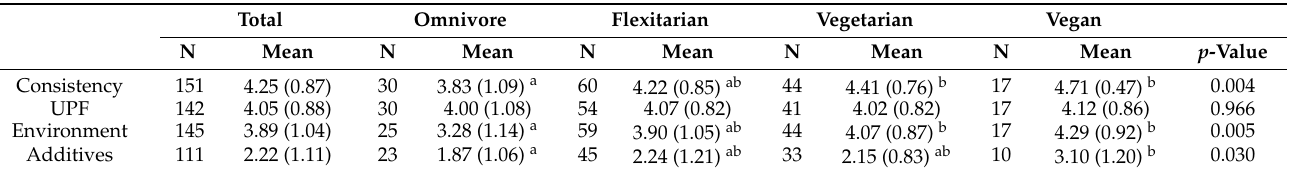
Table 10. Mean scores and standard deviation of the objective knowledge about sustainability characteristics of PBMAs 1 by participants’ diets.